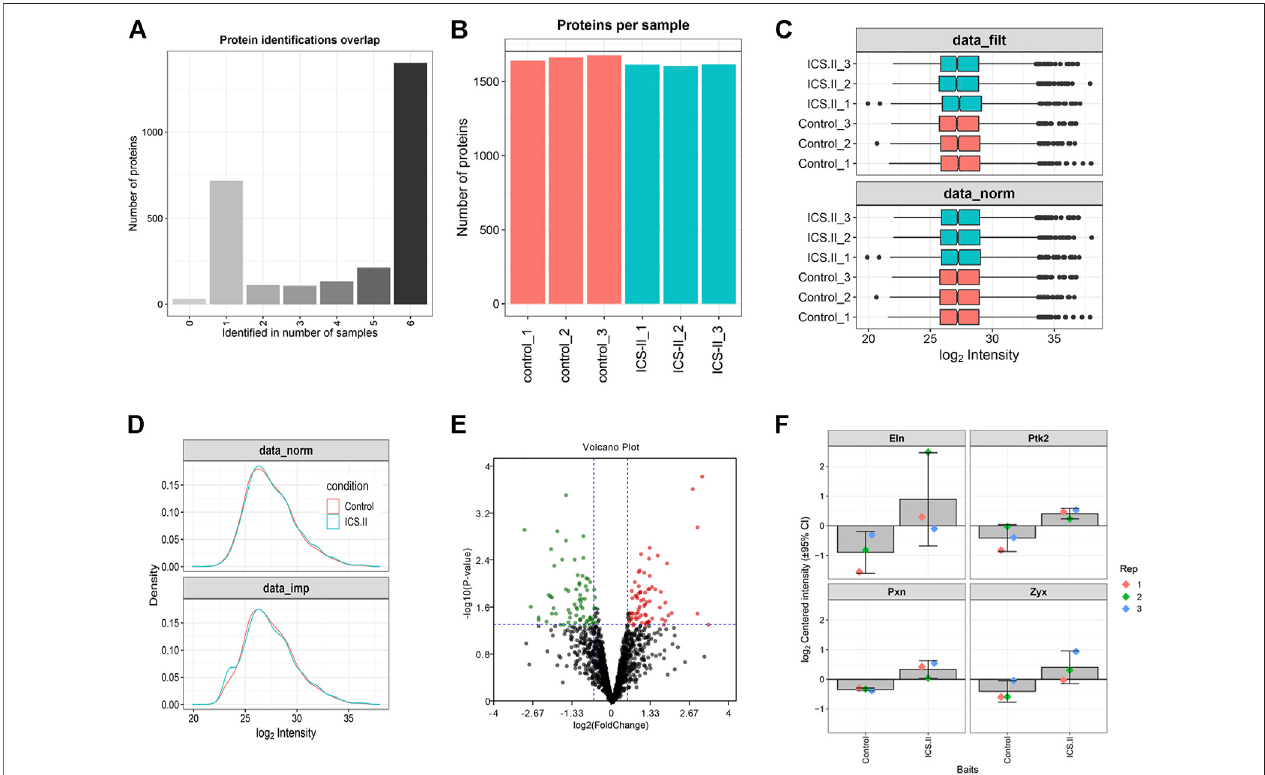
FIGURE 2 | Differentially expressed protein (DEP) analysis after ICS-II intervention. (A) Overlap of protein identi fi cations between samples. (B) The number of identi fi ed proteins per sample. (C) Comparison ofraw and normalized data. (D) Protein intensity distributions beforeand after missingvalueimputation. (E) Volcano plot for DEPs between the ICS-II group and control group. (F) Bar plots of ELN, PTK2, PXN, and ZYX expression levels. ELN: elastin; PTK2: protein tyrosine kinase 2; PXN: paxilline; ZYX: Zyxin.